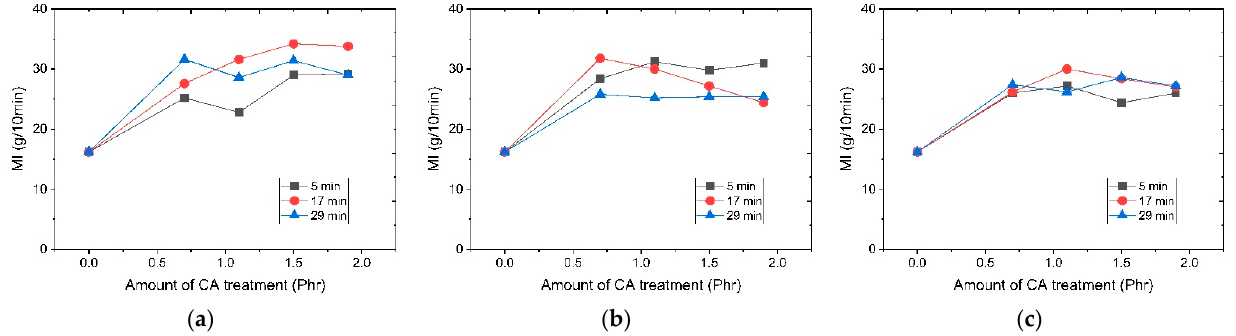
Figure 3. MI graph as a function of surface modification temperature and CA addition amount: ( a ) 130 °C; ( b ) 150 °C; ( c ) 170 °C.